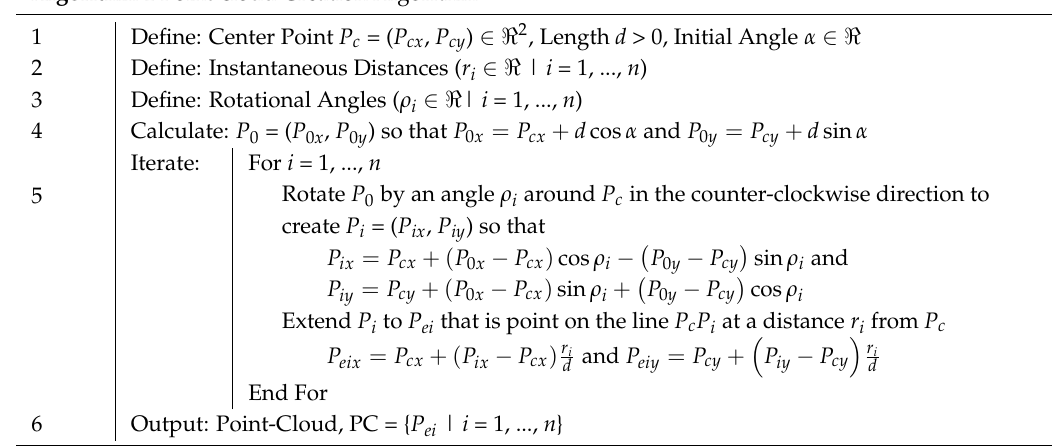
Algorithm 1 Point-cloud Creation